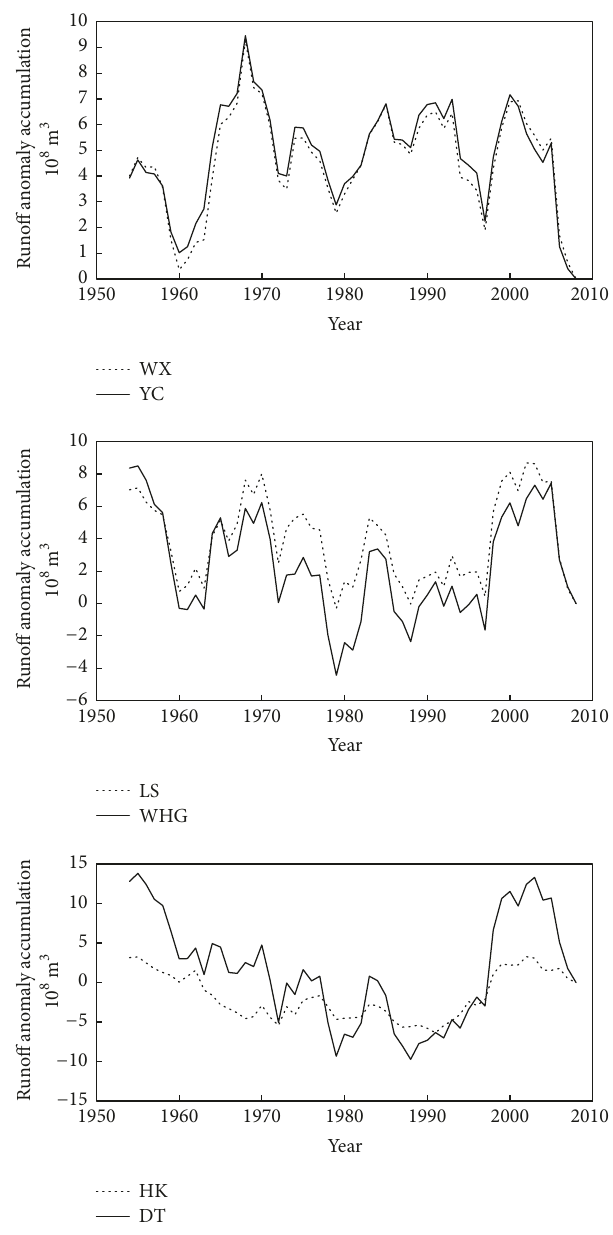
Figure 2: The YRB’s upper, middle, and lower reaches’ cumulative anomaly